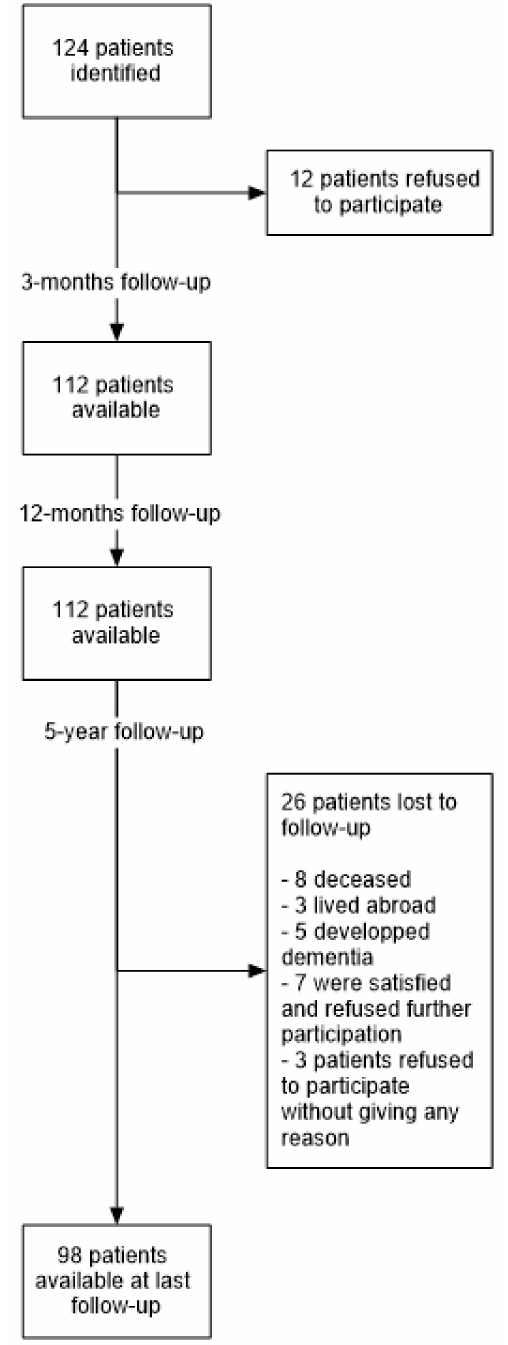
Figure 1. Patients available at each